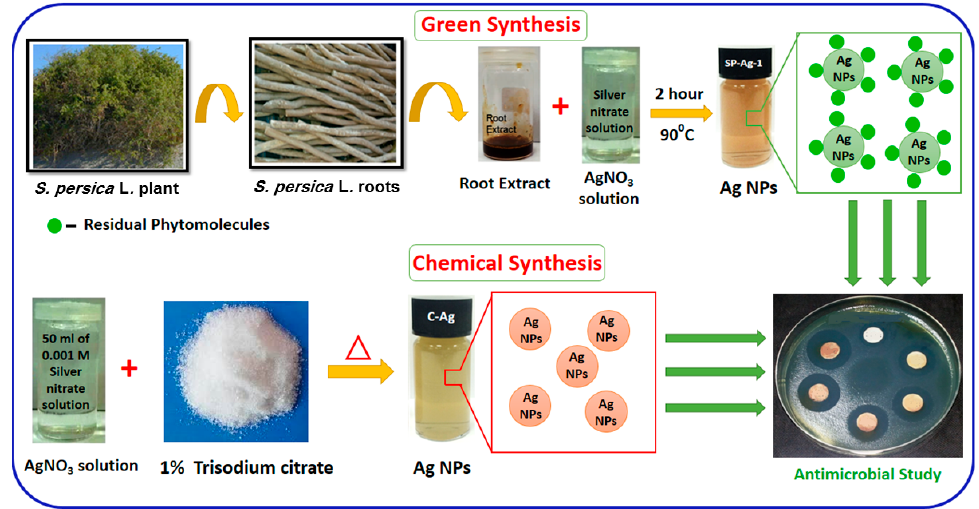
Figure 1. Graphical representation of green and chemical syntheses of silver nanoparticles (Ag-NPs) using S. persica L. RE and trisodium citrate, respectively, and evaluation of their microbicidal activities against various bacterial strains.